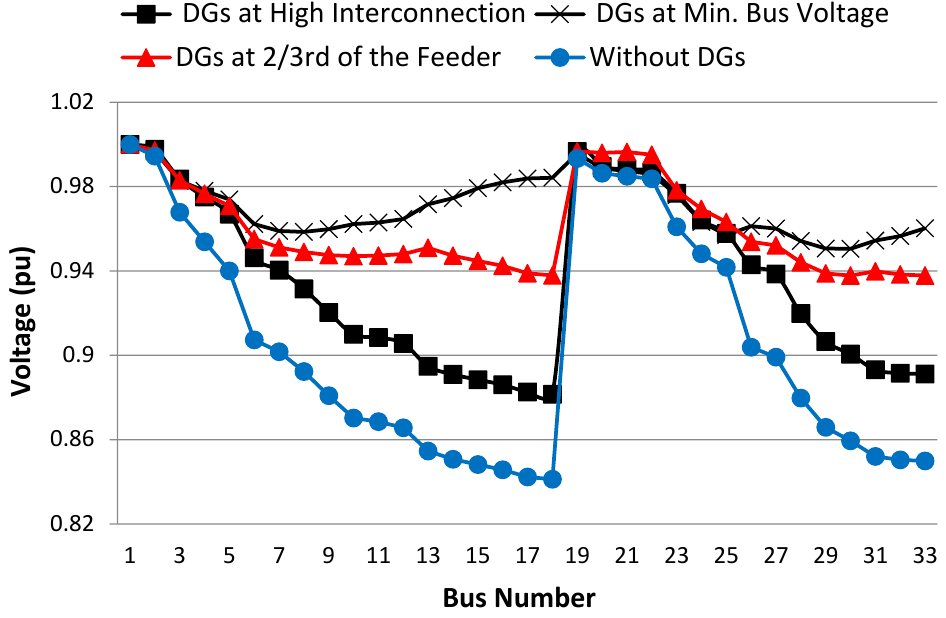
Figure 10. The voltage profile at 150% loading condition.